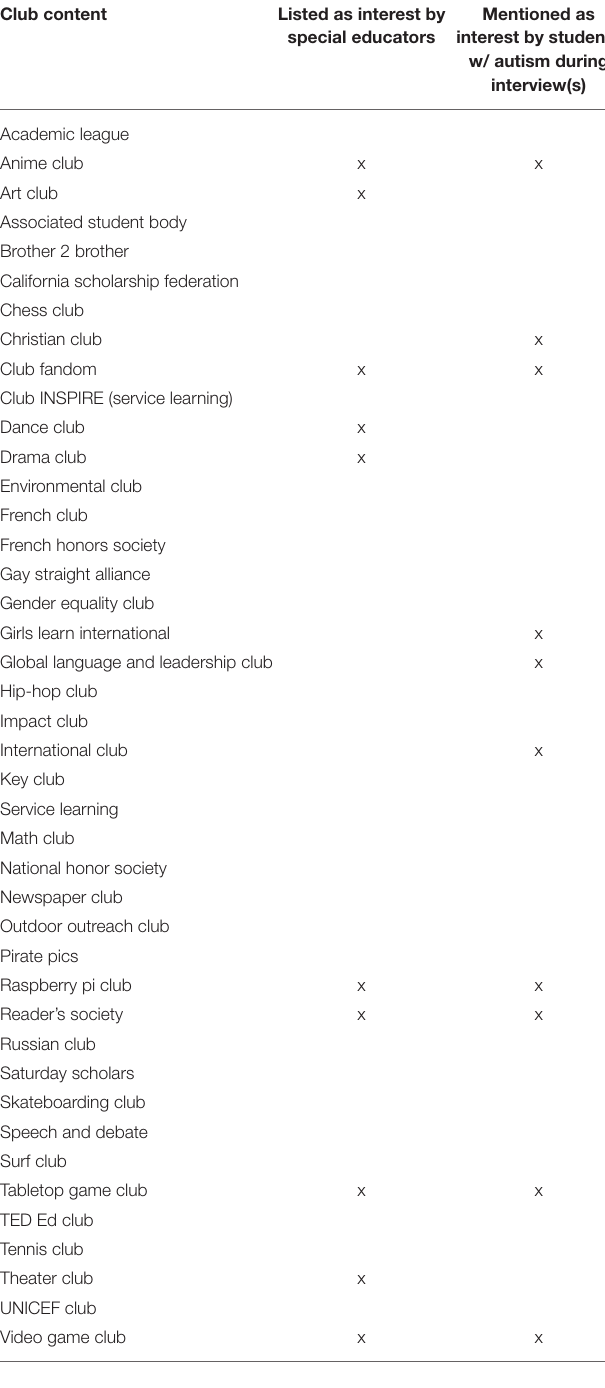
TABLE 2 | Club content of interest reported by special educator survey